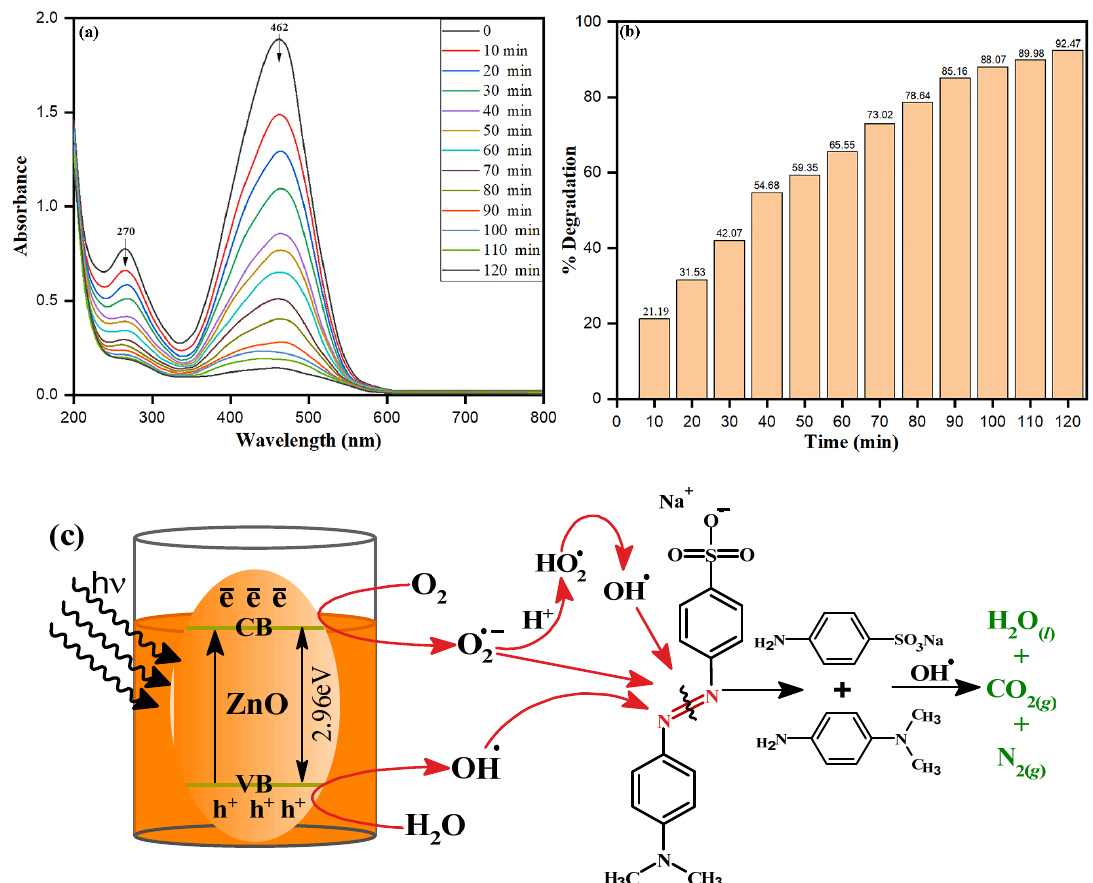
Figure 11. ( a ) Typical absorbance spectra of MO dye in presence of bio ‐ fabricated ZnONPs under UV light, ( b ) MO dye degradation percentage at different time intervals, ( c ) Schematic photocatalytic mechanism of MO dye degradation under UV light. Table 2. Comparison of photocatalytic degradation efficiency of ZnO nanoparticles. Plant Used for NPs